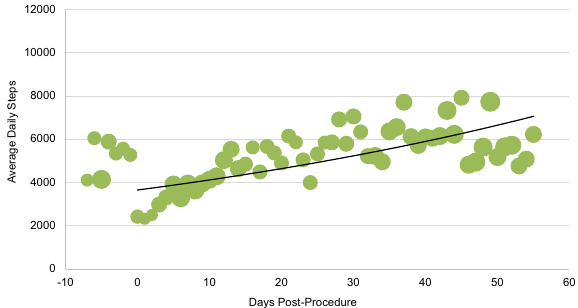
Fig. 2 Average steps per day for patients who underwent bariatric surgery ( n = 29). Bubble size corresponds to number of patients for whom data were synced. Procedure occurred on day 0. Negative days indicate pre-procedure data, when available. Data obtained via Fitbit Charge 2 TM .